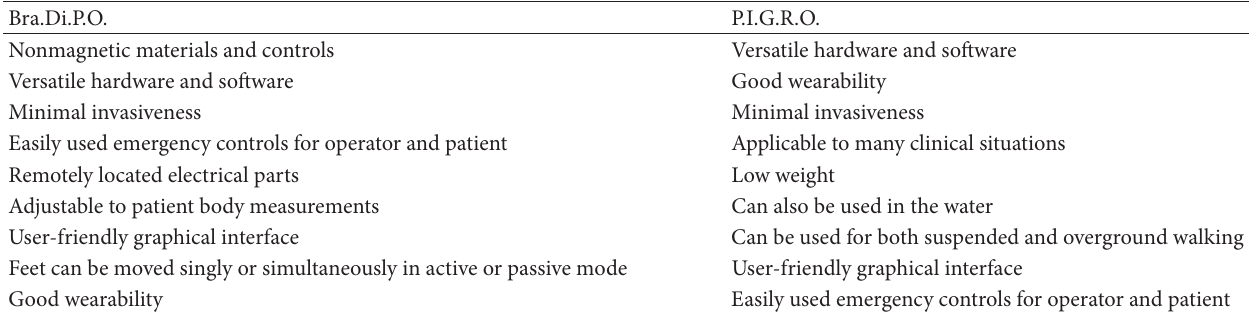
Table 2: Technical features of the two prototypes.